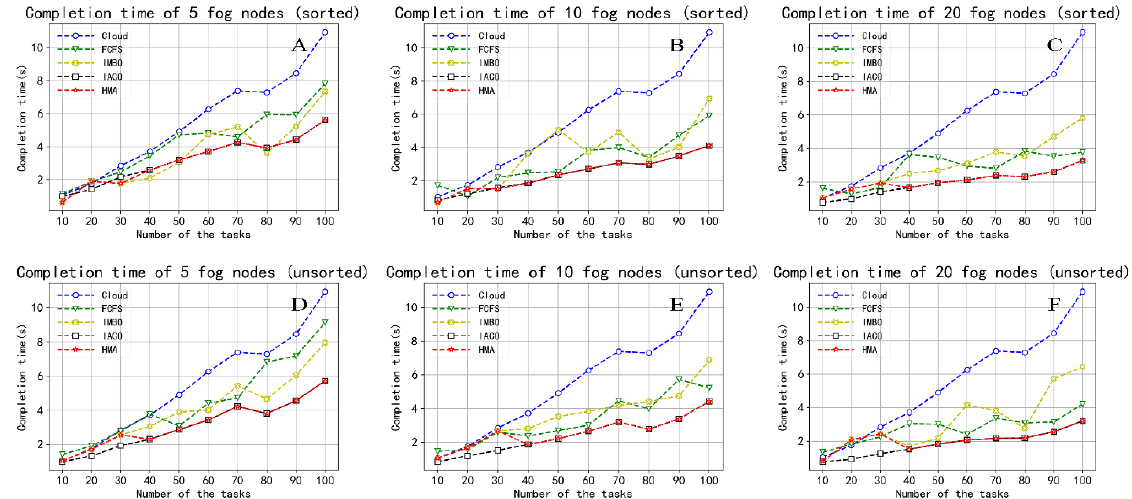
Figure 6. Comparison of the maximum completion time. ( A ) Completion time of 5 fog nodes (sorted); ( B ) Completion time of 10 fog nodes (sorted); ( C ) Completion time of 20 fog nodes (sorted); ( D ) Completion time of 5 fog nodes (unsorted); ( E ) Completion time of 10 fog nodes (unsorted); ( F ) Completion time of 20 fog nodes (unsorted).